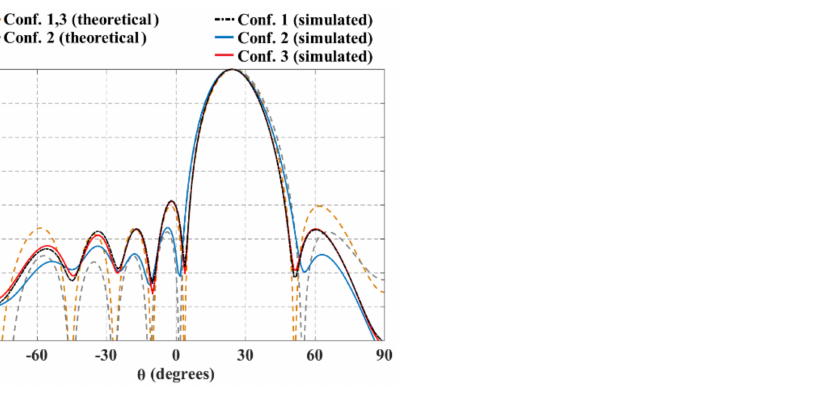
Figure 12. Radiation pattern in elevation for the furthest scanning direction of the three planar array configurations ( φ 0 = 0 ◦ and θ 0 = 25 ◦ ).